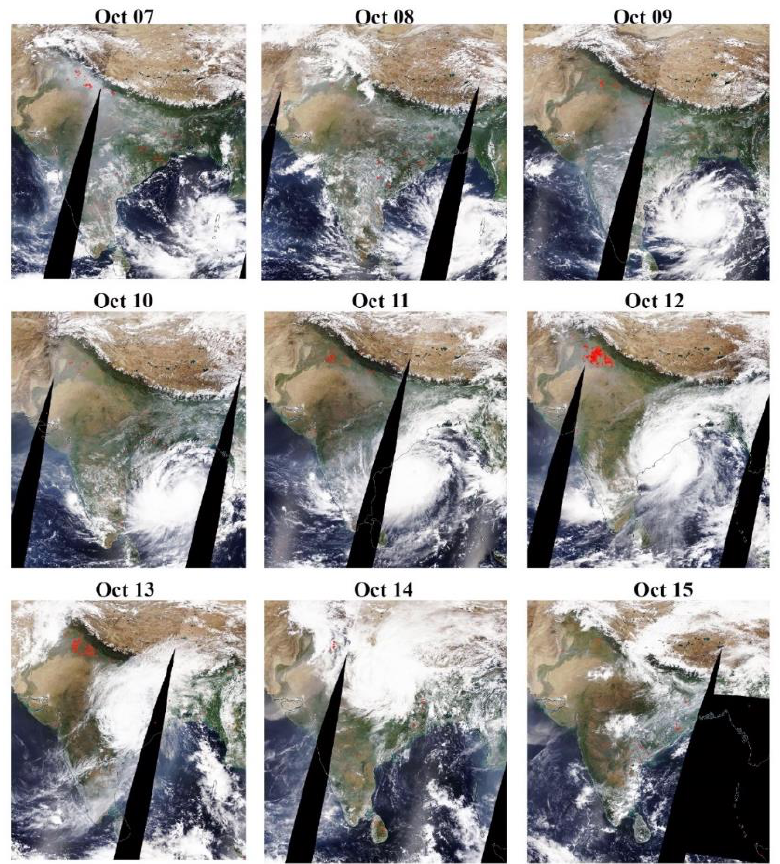
Figure 2. Moderate-resolution imaging spectroradiometer (MODIS) Terra sensor images (7–15 October 2014) showing progress of the Hudhud cyclone and impact over India and Bangladesh. Satellite image (12 October 2014) shows impact of cyclone covering Andhra Pradesh and Odisha states ( https://worldview.earthdata.nasa.gov/ ).